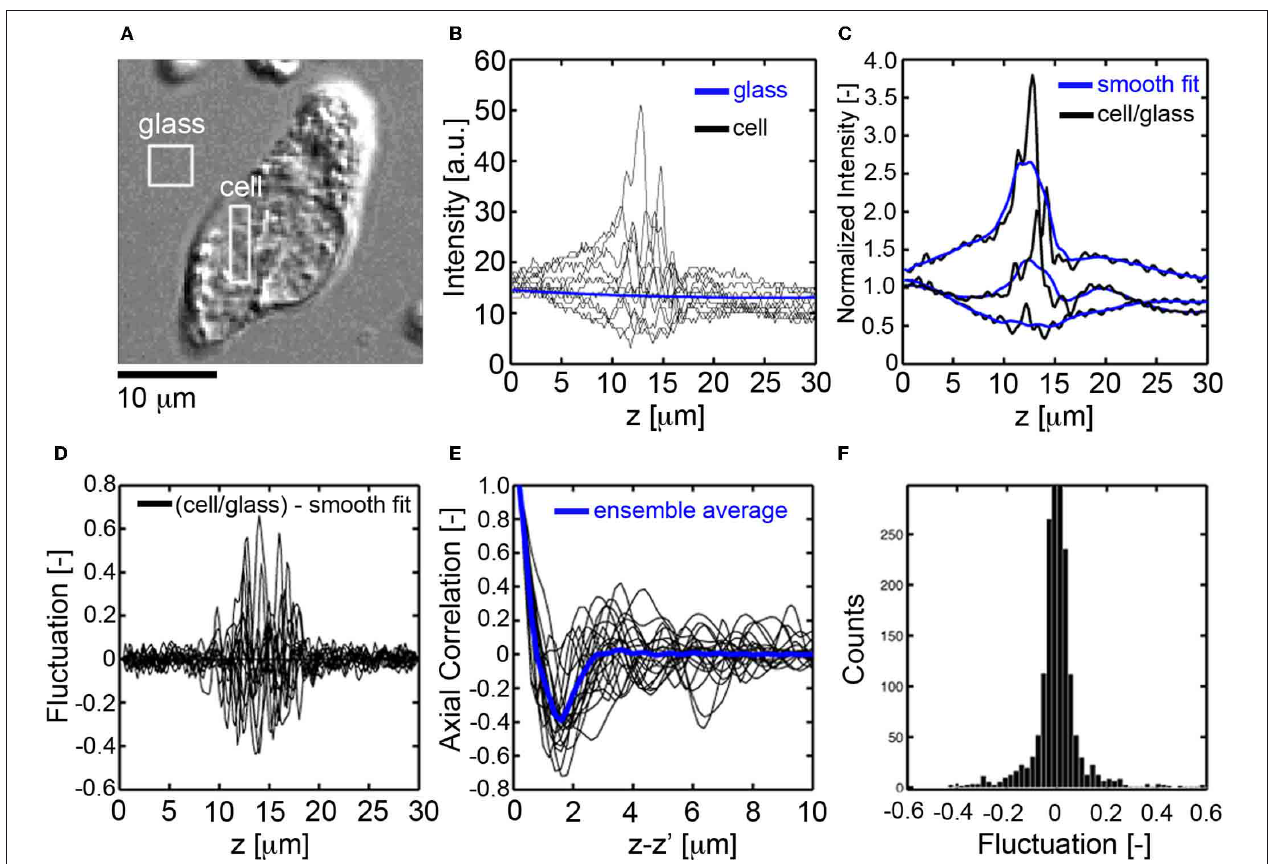
FIGURE 2 | Fluctuation and spatial correlation analysis of axial DIC intensity profiles. (A) En face DIC image CTC. (B) Axial profiles of DIC intensity for pixels in the cell (black) and glass substrate (blue), (C) normalized DIC intensity profile (black, cell signal divided by glass signal) for pixels inside the cell and corresponding smooth fit (blue), (D) fluctuating part of the DIC